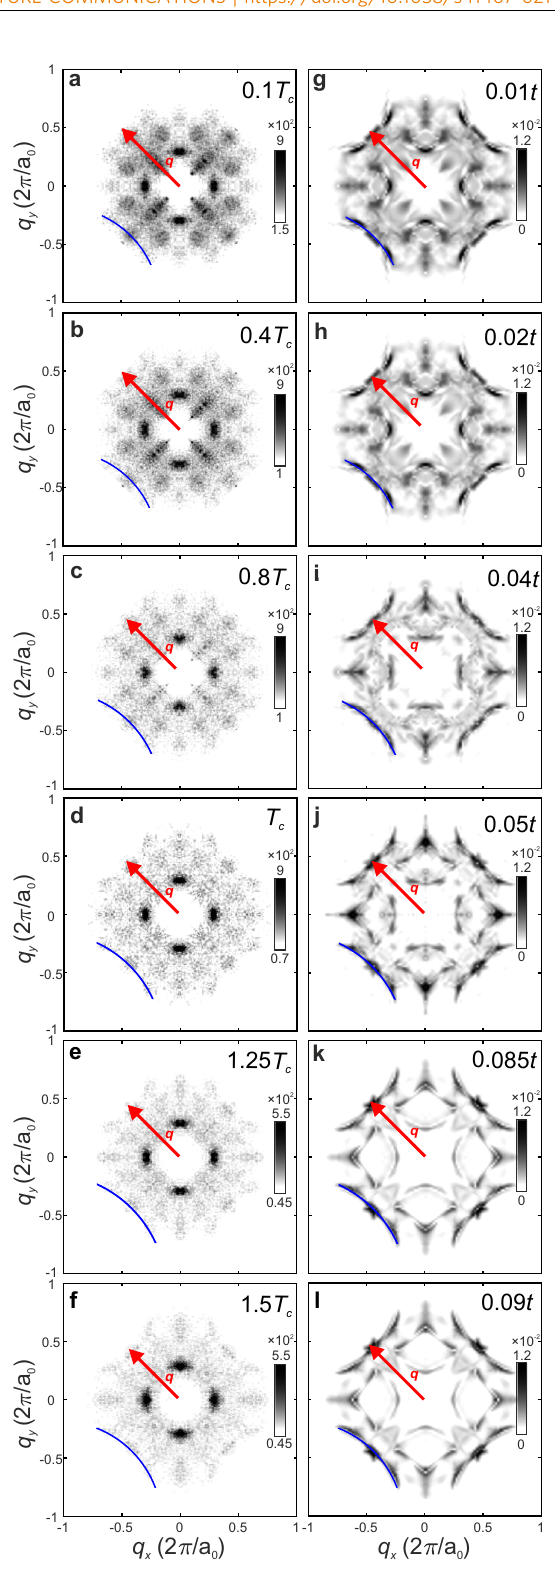
Fig. 4 Temperature Dependence of QPI Signature of a PDW. a – f .